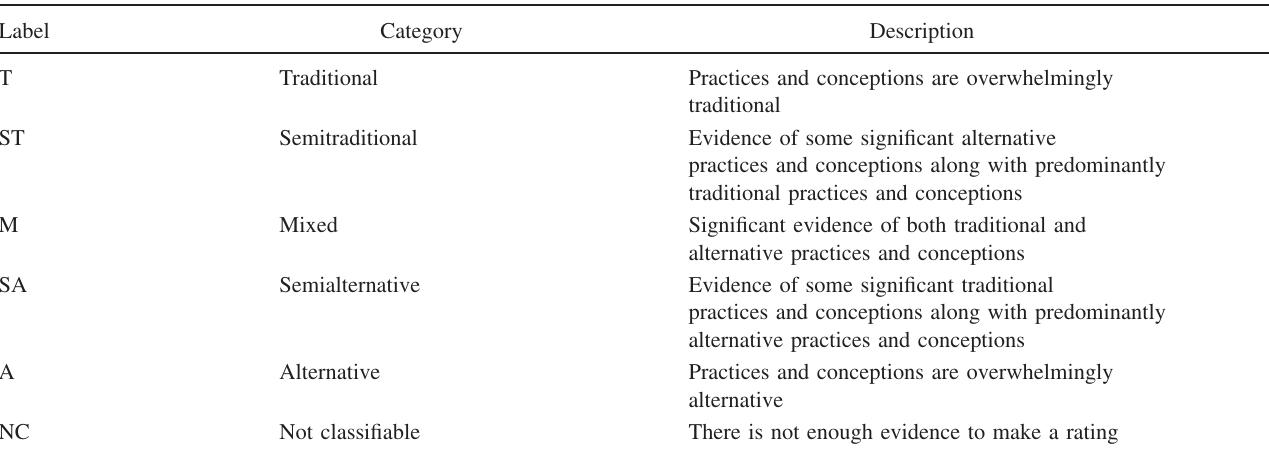
TABLE IV. Categorization scheme used to classify main categories of practices and conceptions for each instructor.